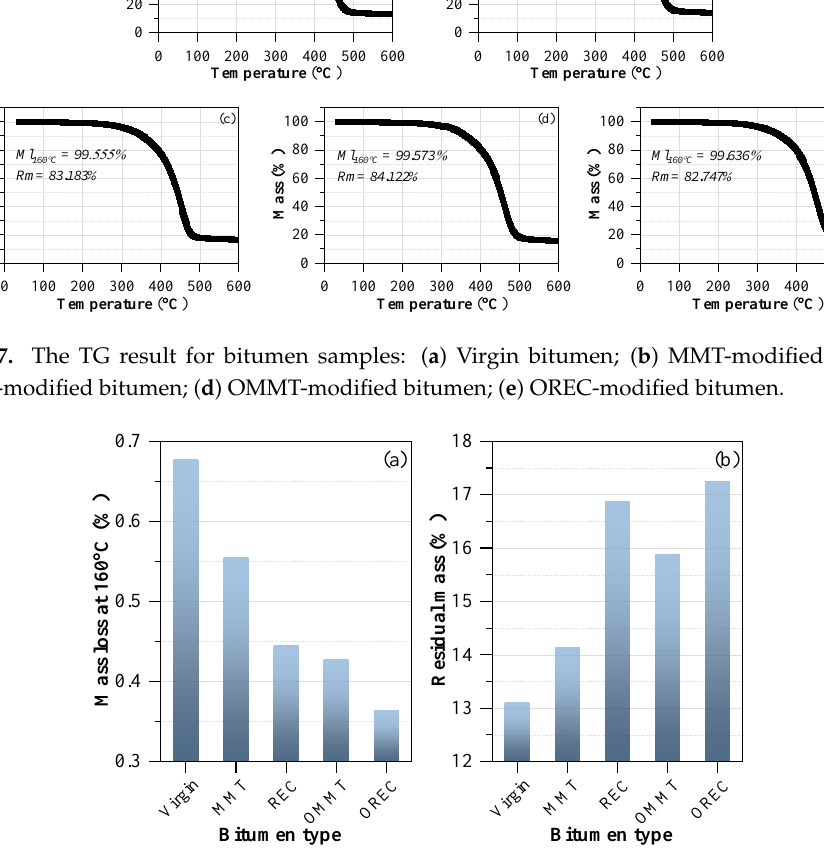
Figure 8. The analysis results for Figure 7: ( a ) Mass loss at 160 ◦ C; ( b ) final residual mass.